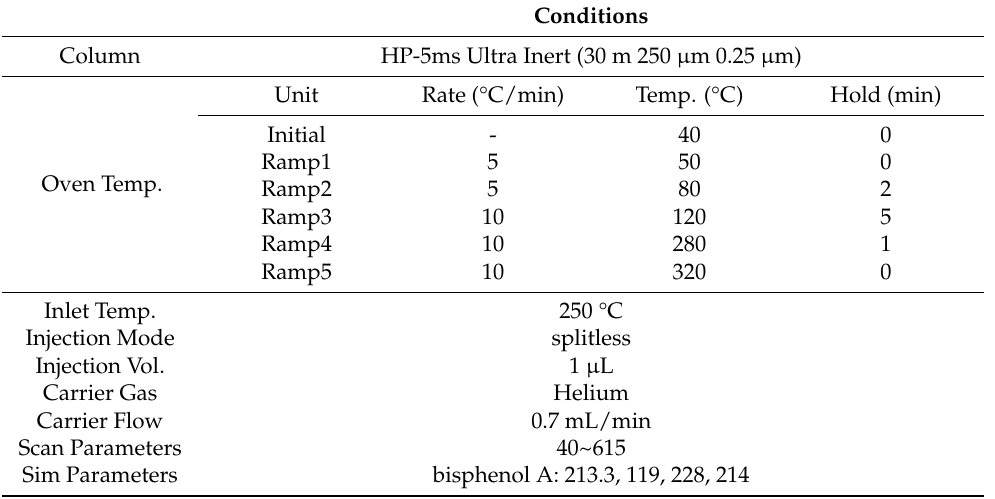
Table 4. Instrument conditions of GC-MS for BPA